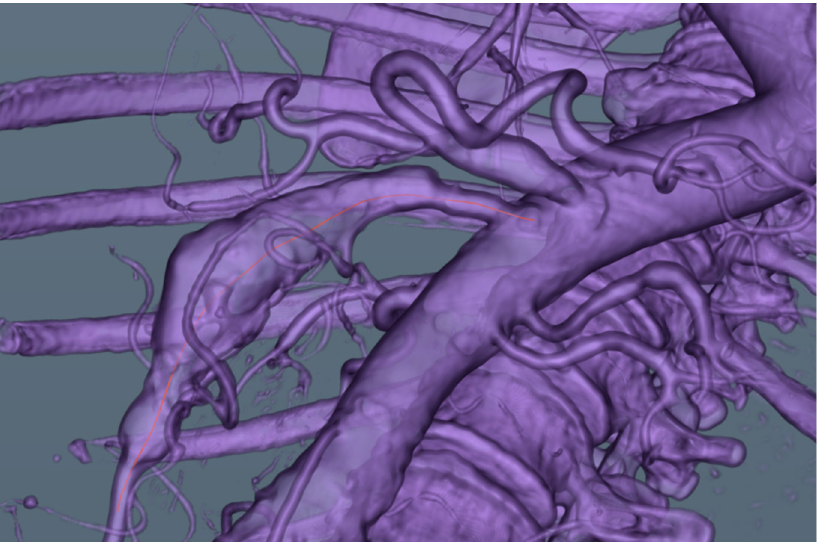
Figure 7. Virtual angiography trajectory—“procedure” started opposite to the blood flow, bottom-up, with the final point into the aorta (direction is opposite to the blood flow).